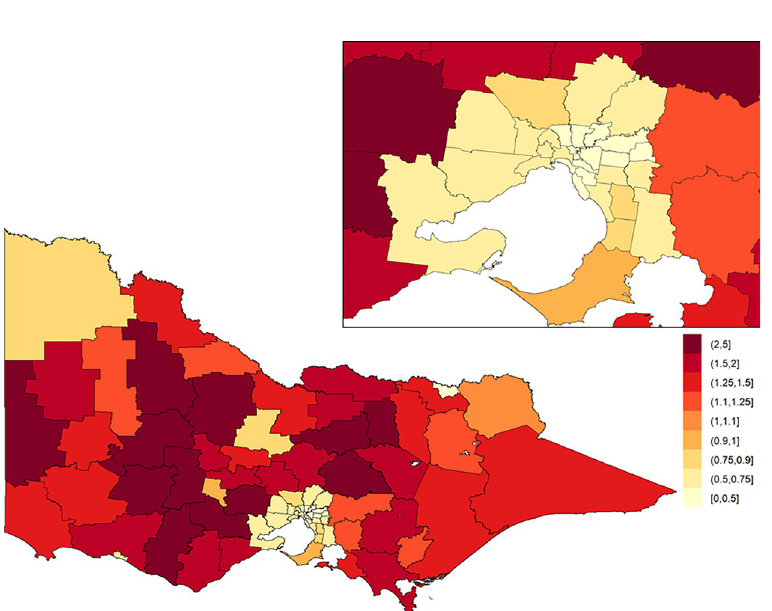
Fig 10. Area-specific yearly multiplicative change in risk of injury by law fall in Victoria. Here, a value of one indicates that the area-specific risk is stable over time; a value greater than one indicates that the area-specific risk is increasing over time; and a value less than one indicates that the area-specific risk is declining over time. The inset on the top-right shows Greater Melbourne.